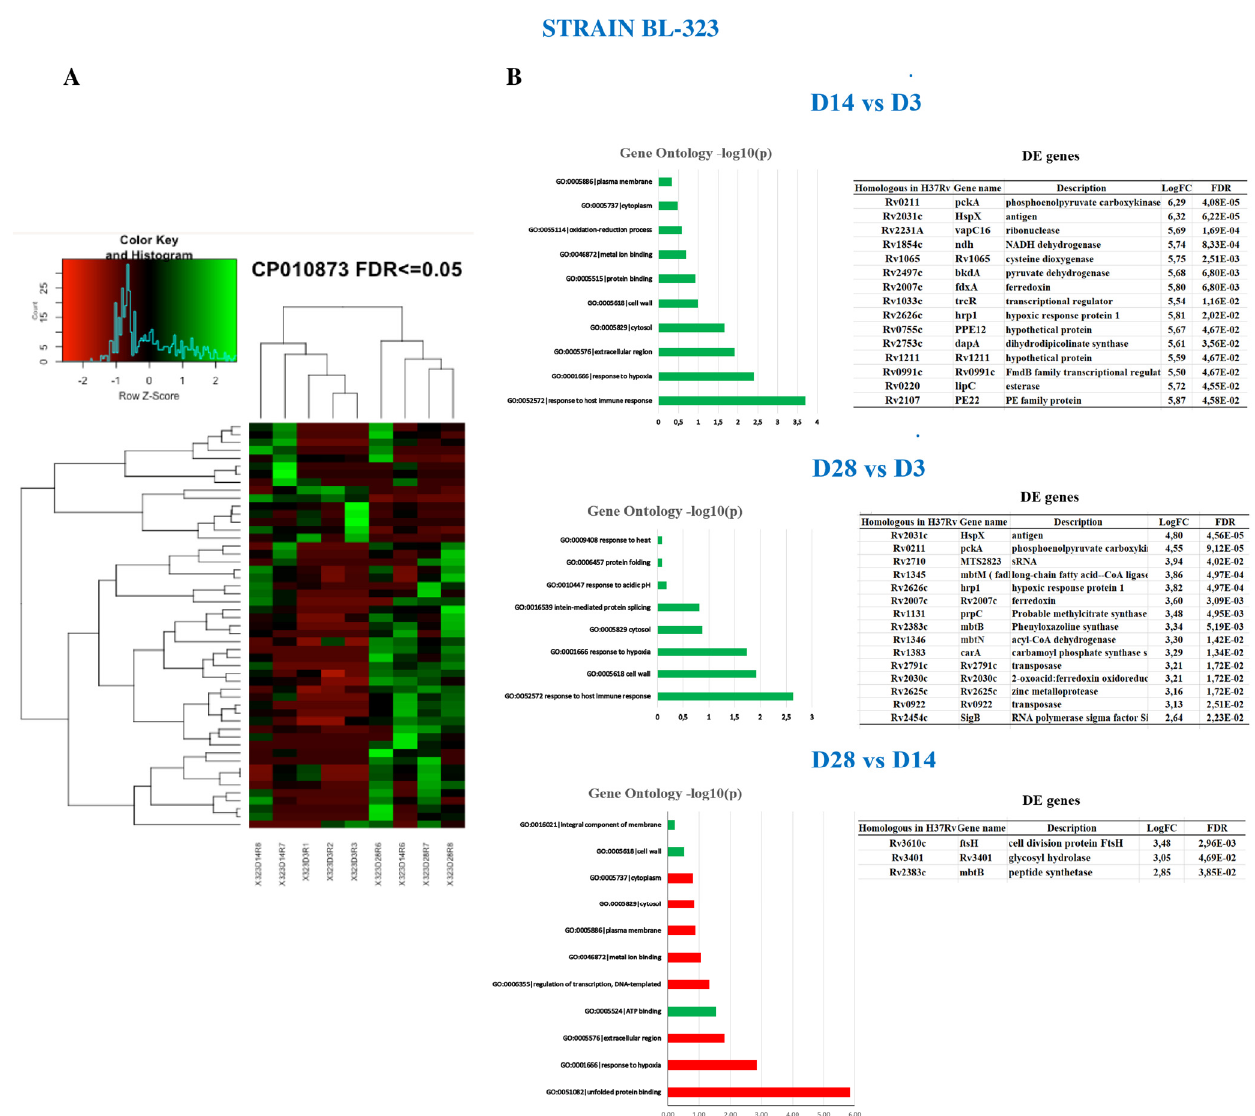
Figure 2. MTB strain BL-323 gene expression differences between days PI. ( A ) Heatmap showing the differentially expressed genes. Overexpressed genes are colored in green whilst under expressed ones are colored in red. Biological replicates were included in the analysis. ( B ) GOA at the different time points of infection ( p -value ≤ 0.05). Green bars are metabolic pathways whose genes are overexpressed on the day of the assay, whilst red bars are metabolic pathways whose genes are more expressed on the day of reference. Only overexpressed genes are displayed in the